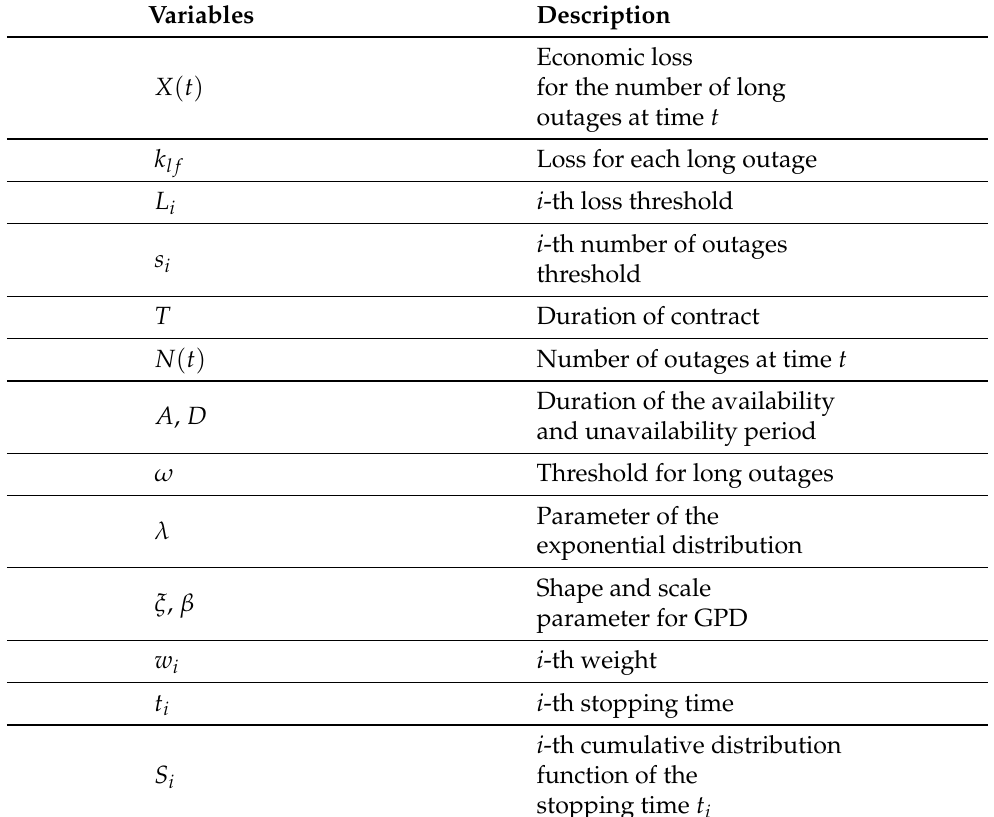
Table 3. Description of variables and parameters